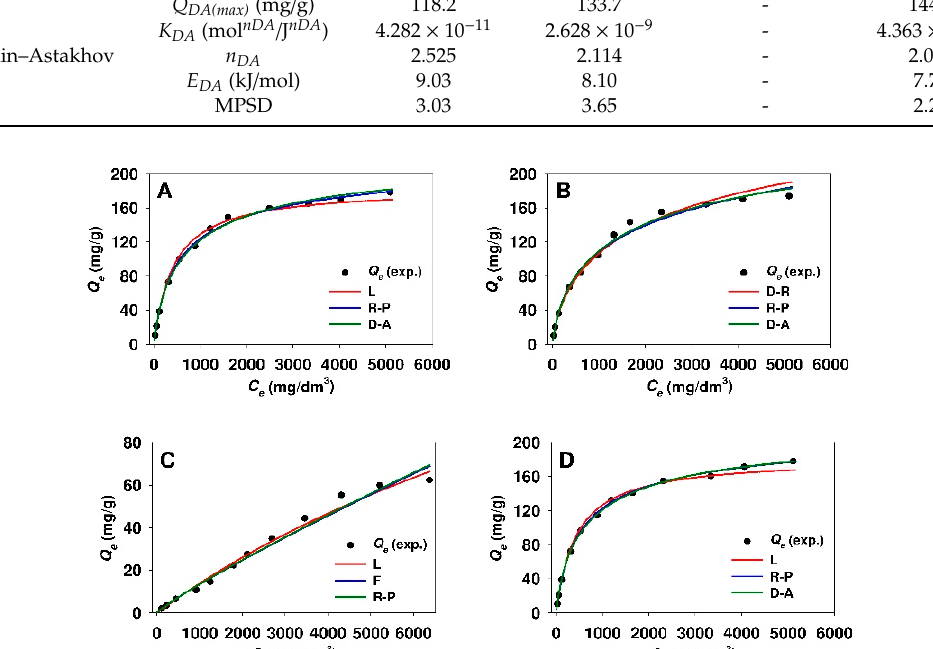
Figure 12. Comparison of experimental and predicted isotherms of 18 β -glycyrrhetinic acid adsorption onto ( A ) SBA-15-AP, ( B ) SBA-15-MAP, ( C ) SBA-15-DMAP, and ( D ) SBA-15-AEAP mesoporous adsorbents. The best fitted isotherm models derived from nonlinear fitting analysis are presented. Isotherm models: F, Freundlich; D-A, Dubinin-Astakhov; D-R, Dubinin-Radushkevich; L, Langmuir; R-P, Redlich-Peterson.